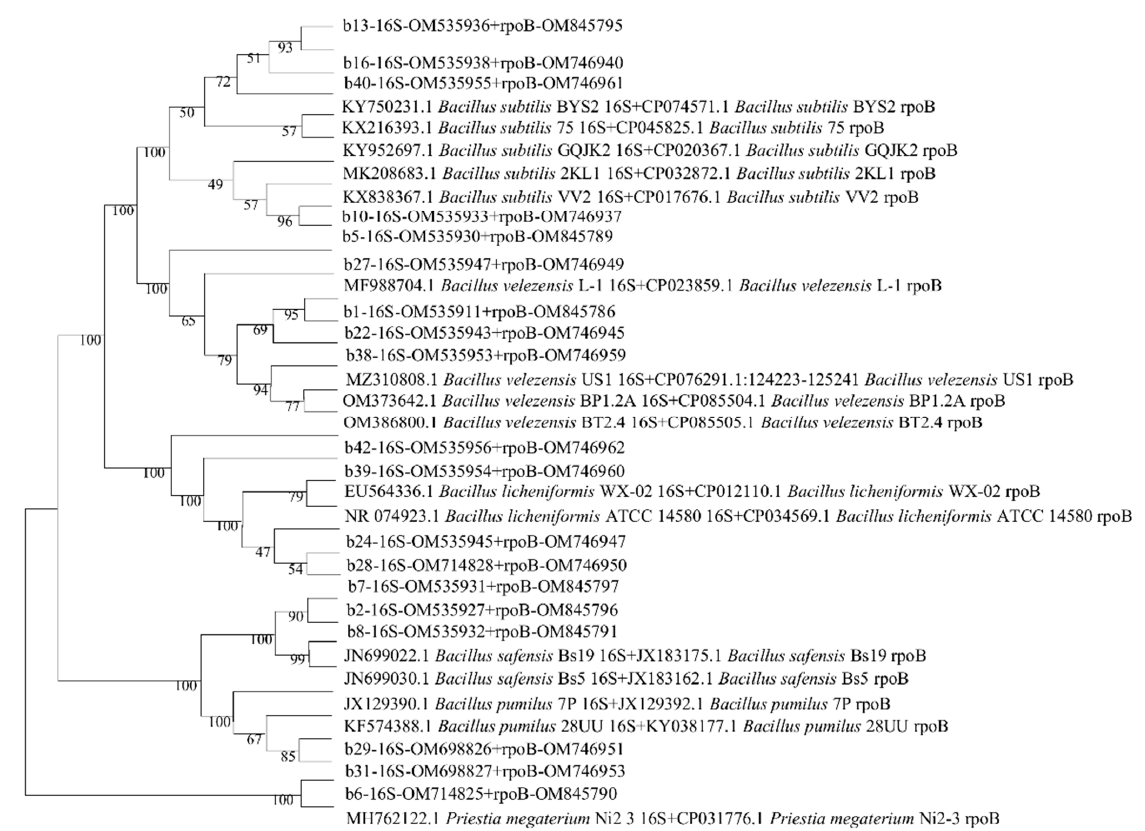
Figure 2. Neighbor ‐ joining phylogenetic tree based on rpoB and 16S rRNA gene sequences of endophytic bacterial strains. Bootstrap values of 1000 replications are shown next to the branches.